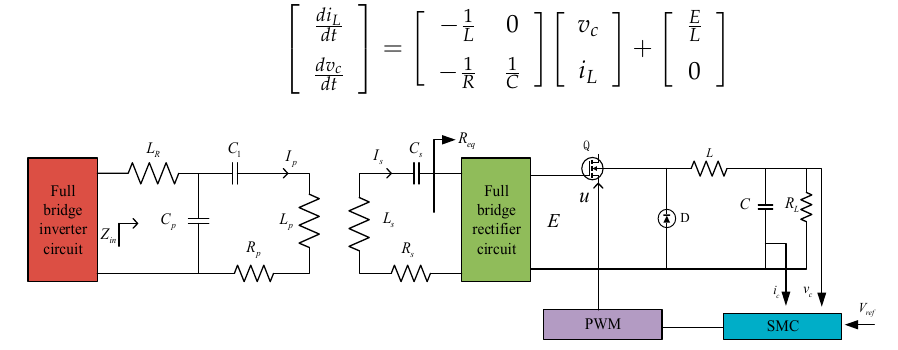
Figure 5. System topology with sliding mode control.